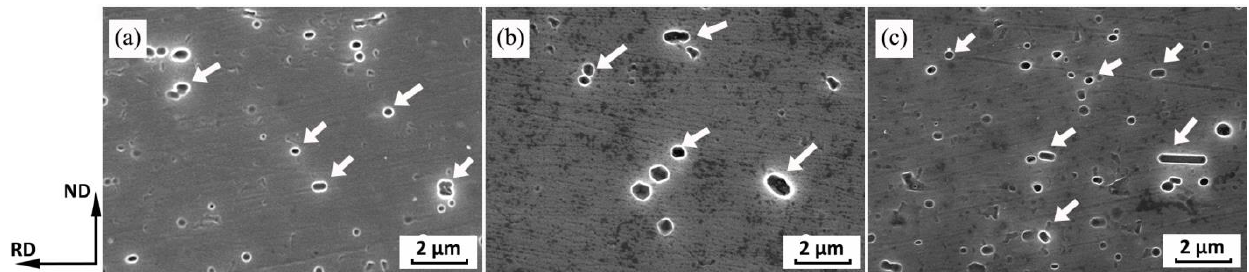
Figure 8. SEM microimages of the precipitate evolution in the core layer of three experimental alloys after brazing: ( a ) Sample A, ( b ) Sample B, ( c ) Sample C.